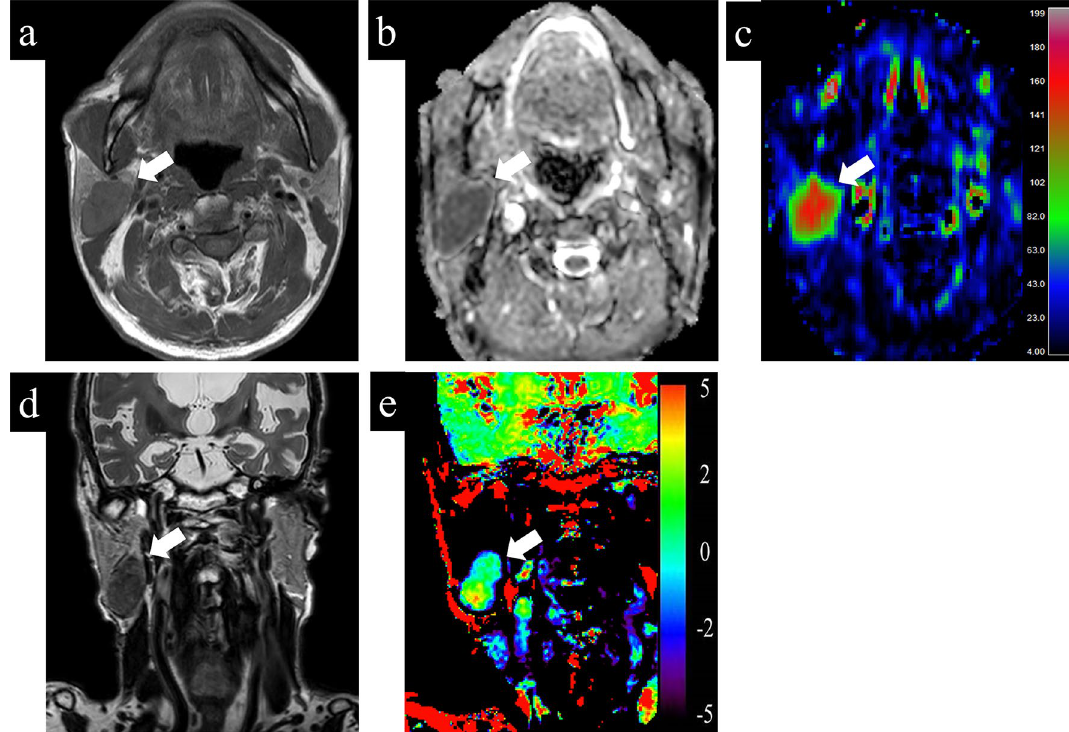
Figure 5. A 79-year-old male with Warthin tumor. ( a ) T1-weighted image shows a homogeneous low intensity lesion in the right parotid gland. Apparent diffusion coefficient (ADC) ( b ) and tumor blood flow (TBF) ( c ) maps show the lesion with the mean ADC value of 0.85 × 10 −3 mm 2 /s and the mean TBF value of 133.06 mL/100 g/ min, respectively. On T2-weighted coronal image ( d ), the lesion shows lower signal intensity than the adjacent parotid gland parenchyma. Amide proton transfer (APT) ( e ) map shows the lesion with the mean APT-related signal intensity of 1.24%. An arrow in each image indicates the